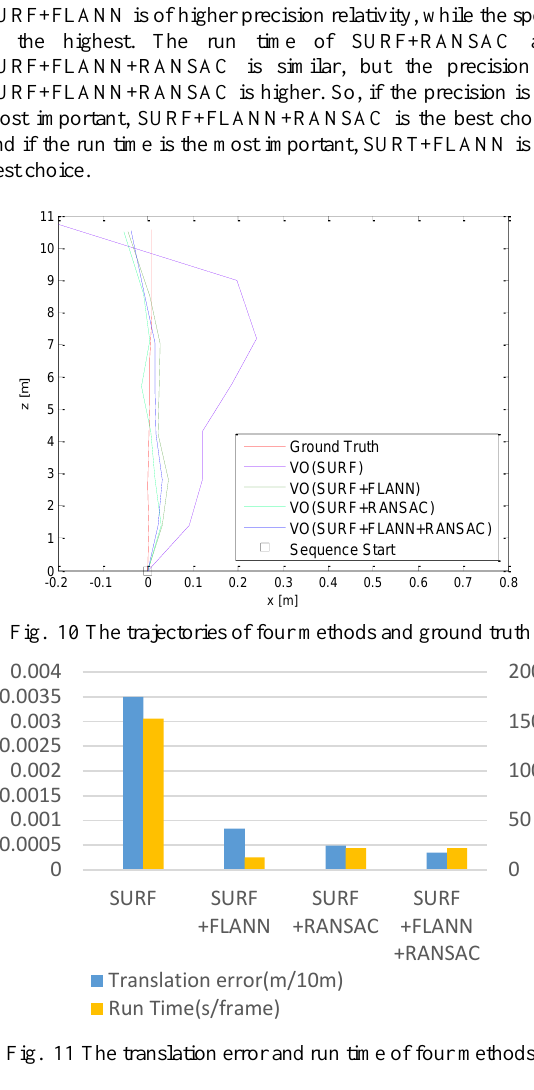
Fig. 12 Images of the calibration board